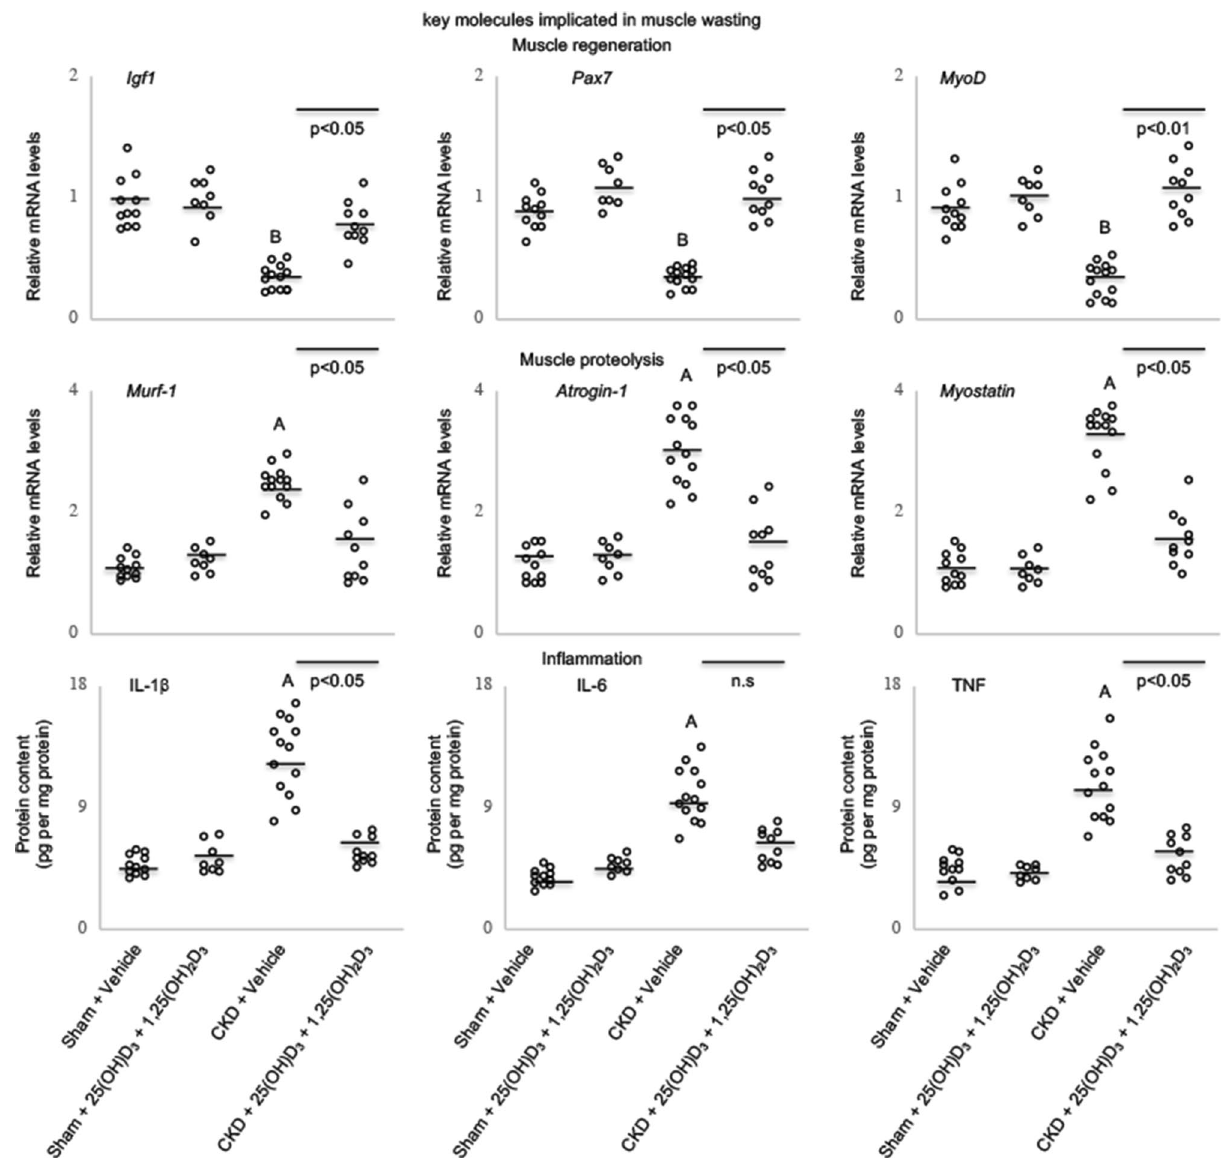
Figure 6. Vitamin D repletion modulates muscle mass signaling pathways in CKD mice. Gene expression of key molecules associated with muscle regeneration (IGF-1, Pax7 and MyoD), myogenesis (Murf-1,